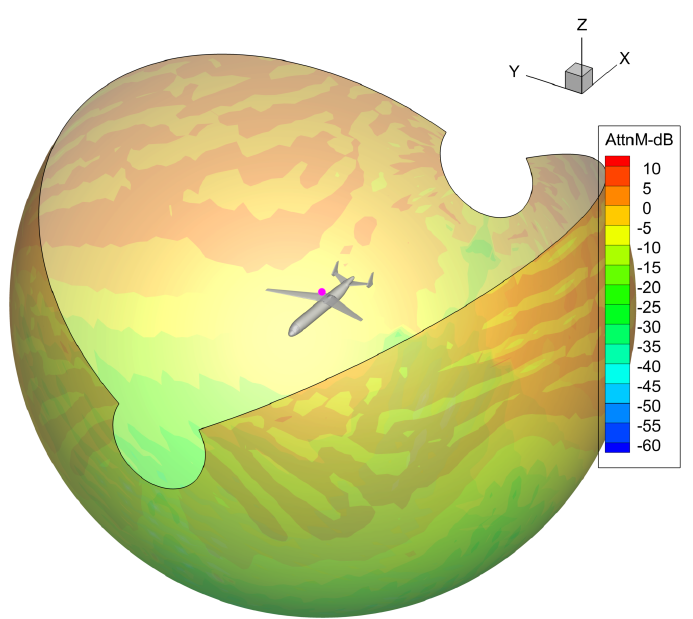
Figure 3. Representation of the delta levels (Attn–dB) provided by SHADOW, on sphere with a radius of 50m for a frequency of 1000 Hz. The pink dot represents the simulated source